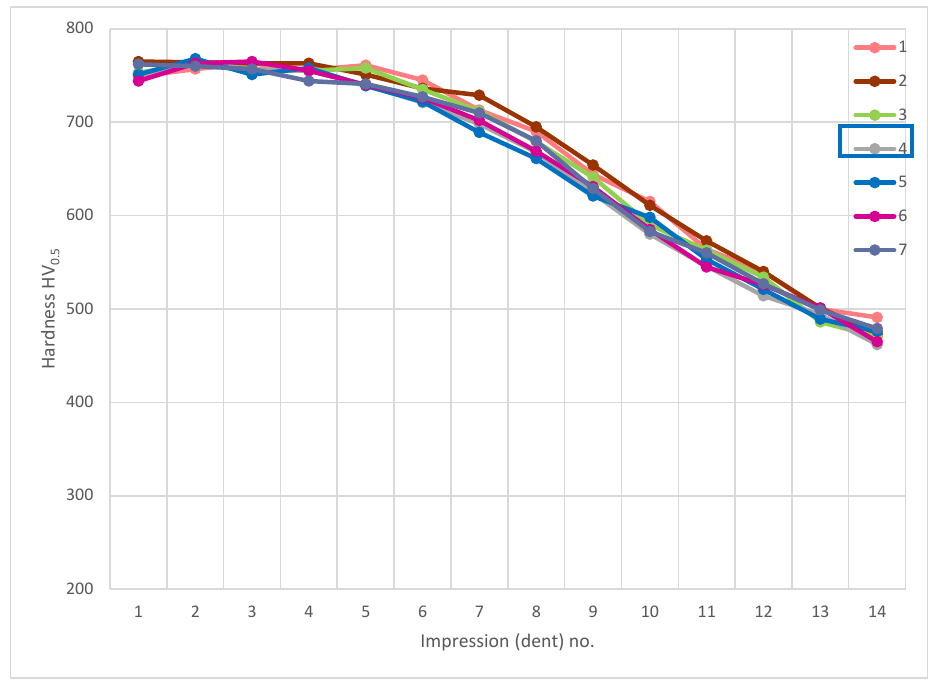
Figure 16. Pattern of hardness verification. Cross-section G1-G1, zone: 3C.